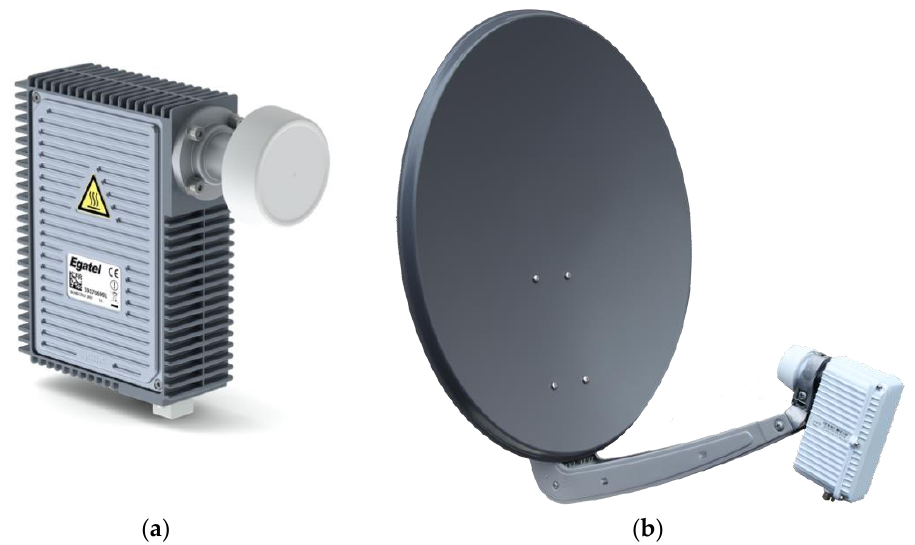
Figure 7. SmartLNB Gen3 terminals from Egatel ( a ) and Ayecka ( b , mounted on a